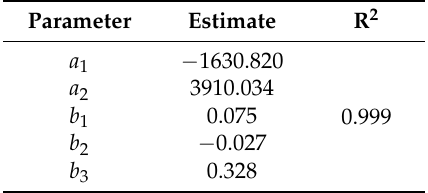
Figure 4. Match of the predicted viscosity values of sCO 2 foam using Equation (6) with the experimental data. Table 2. Parametric estimates of the sCO 2 foam viscosity model (Equation (6)).